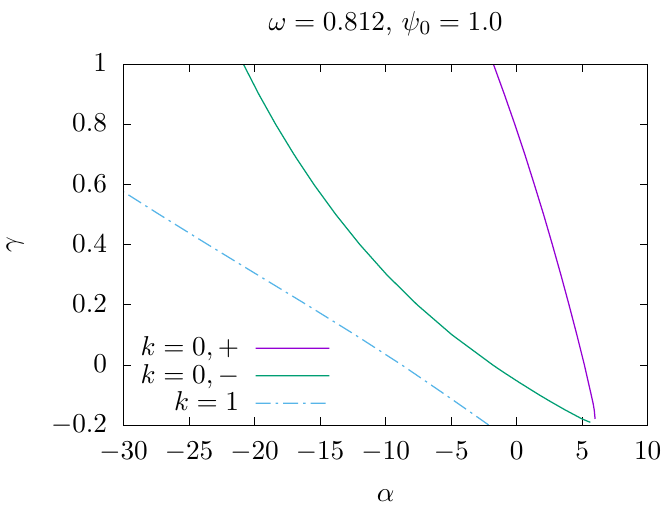
Figure 6 . We show the value of γ in dependence on α for which solutions to (3.4) exist in the background space-time of a boson star with ψ 0 = 1 . 0 corresponding to ω = 0 . 812. We show the two branches that exist for k = 0 (+: purple solid and branch of solutions with one node, i.e. k = 1 (blue dotted-dashed). Note that + and the solutions that exist for positive and negative α , respectively, in the γ = 0